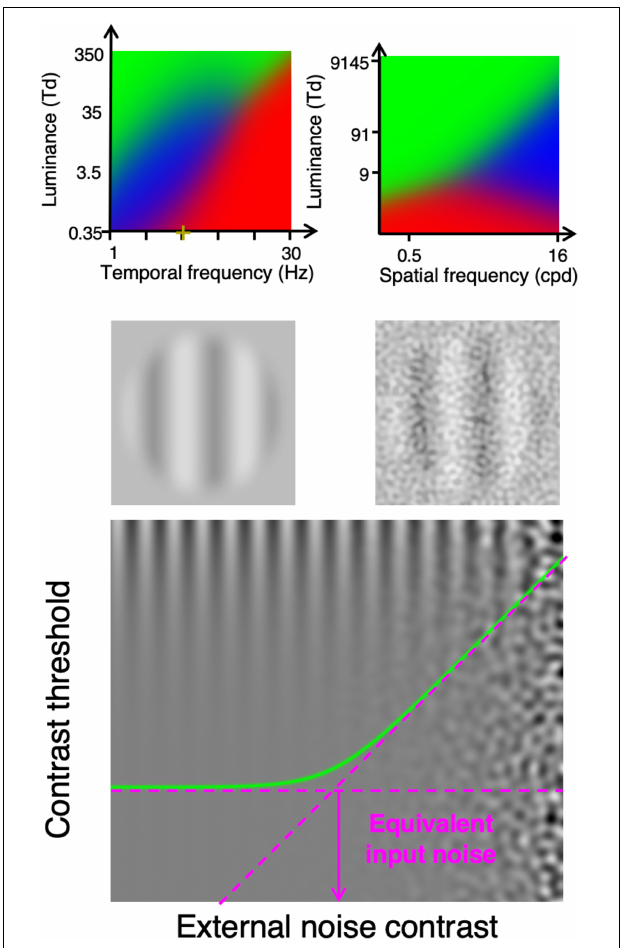
FIGURE 1 | Top row: Dominant noise source identified based on psychophysically measuring contrast sensitivity as a function of luminance intensity. The blue area shows the viewing conditions (luminance intensity and temporal frequency for left graph (Allard and Arleo, 2017), luminance intensity and spatial frequency for right graph (Silvestre et al., 2018) at which the de Vries-Rose law was observed suggesting that the limiting internal noise source is photon noise (variability in the number of photons detected by cones). The green and red areas show conditions in which the Weber law and the linear law were observed, respectively. Second row, stimuli example used to functionally evaluate the detection of light by cones. Bottom graph shows contrast threshold as a function of external noise contrast, which can be used to evaluate the impact of the internal noise (equivalent input